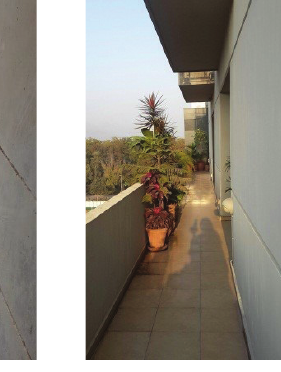
Figure 9. Garbage point in front of S.U. house